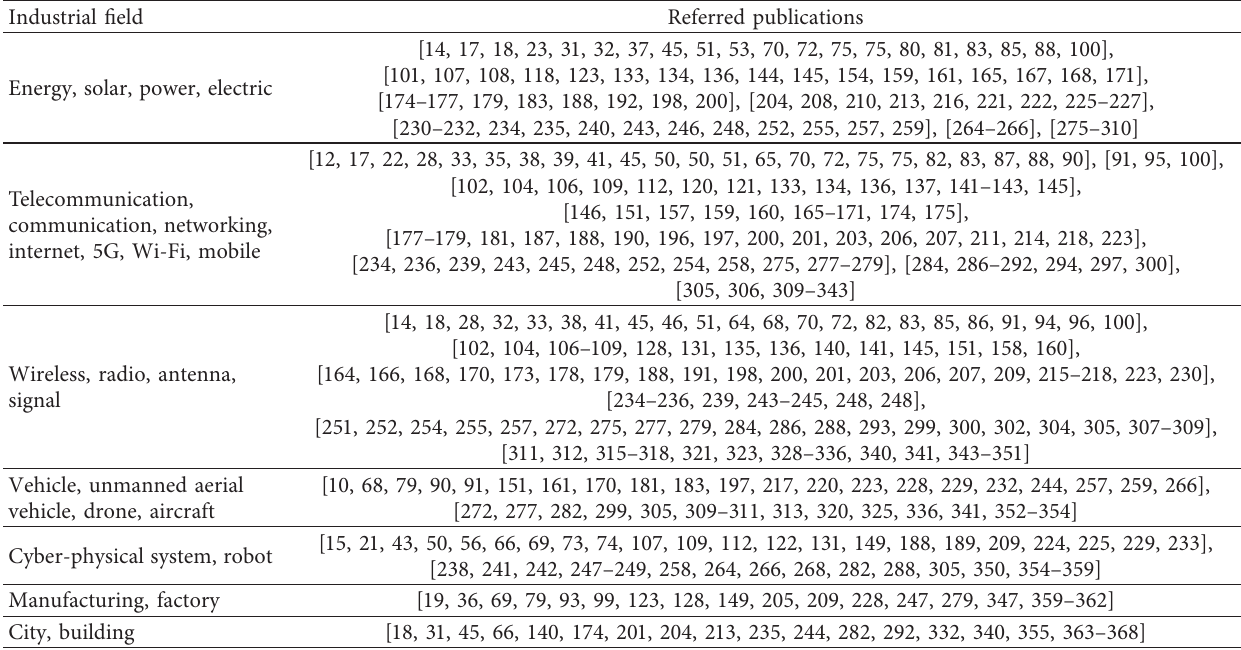
Table 3: Publication reference by industrial field of